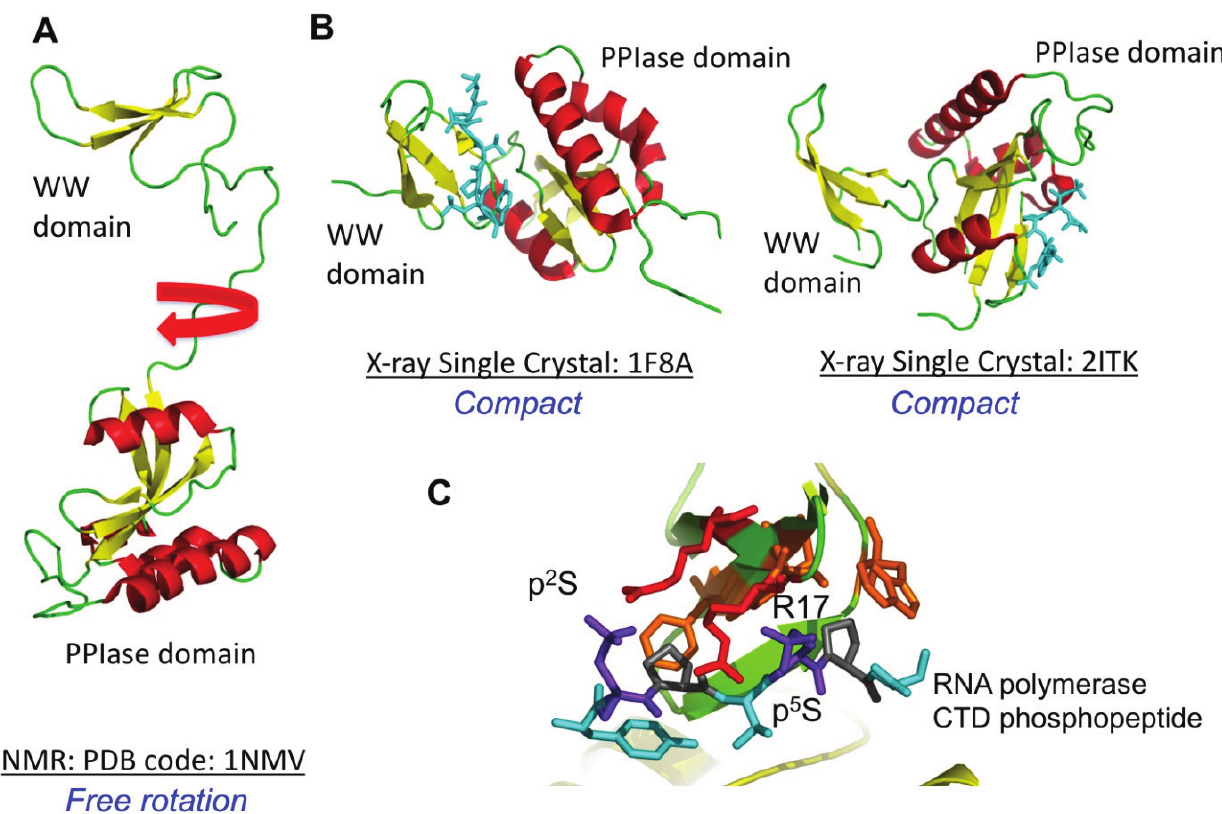
Figure 4. NMR and X-ray crystal structures of Pin1 free and bound to peptides are shown. In ( A ), the solution NMR structure (PDB code 1NMV) is depicted showing the Pin1 PPIase domain and the WW domain separated by a linker; In ( B ) two crystal structures of Pin1 bound to phosphopeptides are shown. In the first structure (PDB code 1F8A), the peptide interacts with the WW domain and in the second complex (PDB code 2ITK), the peptide interacts with the PPIase domain; In ( C ), the interactions of the WW domain with a doubly phosphorylated Ser-Pro peptide is shown. The phosphoserines are shown in blue and the arginine side chains from the WW domain are shown in